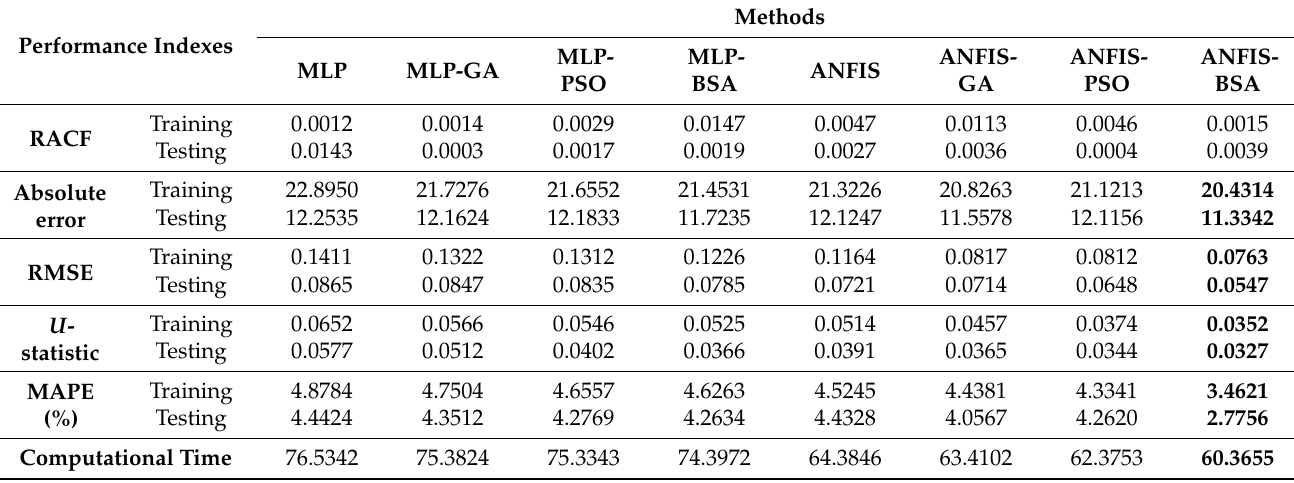
Table 6. Comparison performance indexes of multiple metaheuristic techniques corresponding to the forecasting accuracy for EPF in May 2018 in QLD.